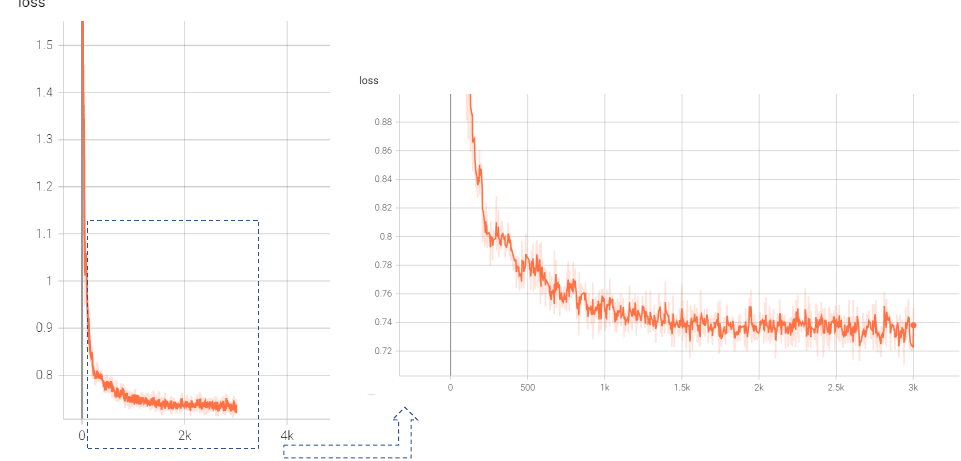
Figure 9. The change in the loss value in 3000 steps of model